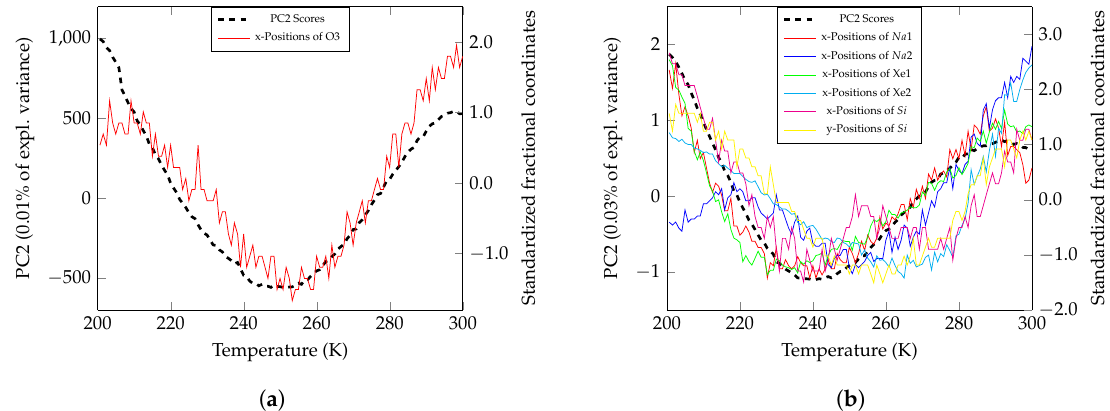
Figure 7. PC2 scores vs. standardized fractional co-ordinates of different atoms for both gases. Fractional co-ordinates were standardized to enhance variation of each atom avoiding scale errors. In ( b ), the curve relative to Na1 (red curves) had the sign changed, as its position chances was negatively-correlated with PC2. ( a ) PC2 scores vs. standardized fractional co-ordinates of O3 atom for CO 2 ramp-up data. ( b ) PC2 scores vs. standardized fractional co-ordinates of different atoms for Xe ramp-up data.